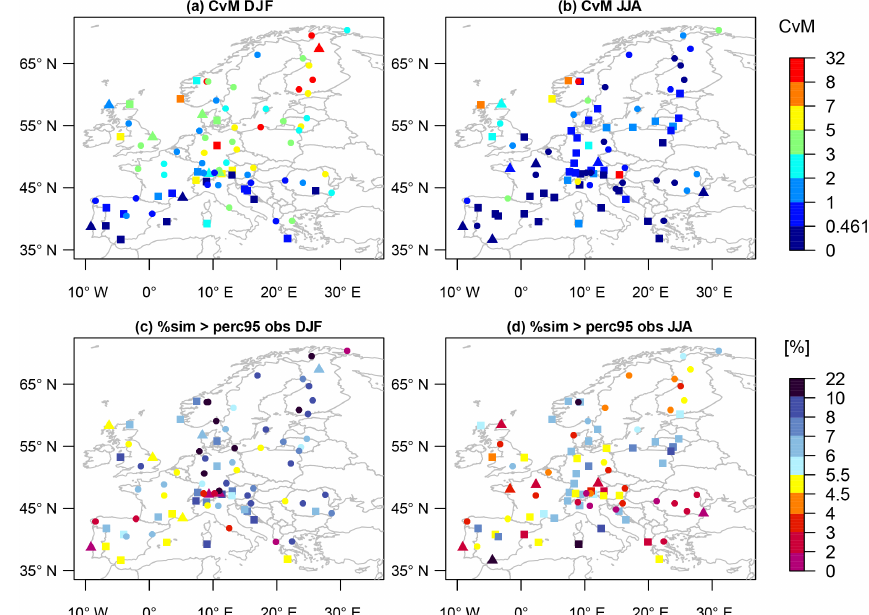
Figure 8. Steps 1 and 2: combined model. (a, b) CvM values for the selected cross-validated model. The threshold for values under which the model cdf is not statistically significantly different at the 95% level from reference cdf: 0.461. (c, d) Percentage of cross-validated model values exceeding the 95th percentile of station observations (%sim > perc95 obs ) for the cross-validated CvM-selected model. For the VGLM the criteria were computed for 100 realizations and then averaged. Selected model: squares: combined model (predictor and VGLM); circles: QM grid -corrected RCM; triangles: uncorrected RCM. Note the different color scales than in Fig.